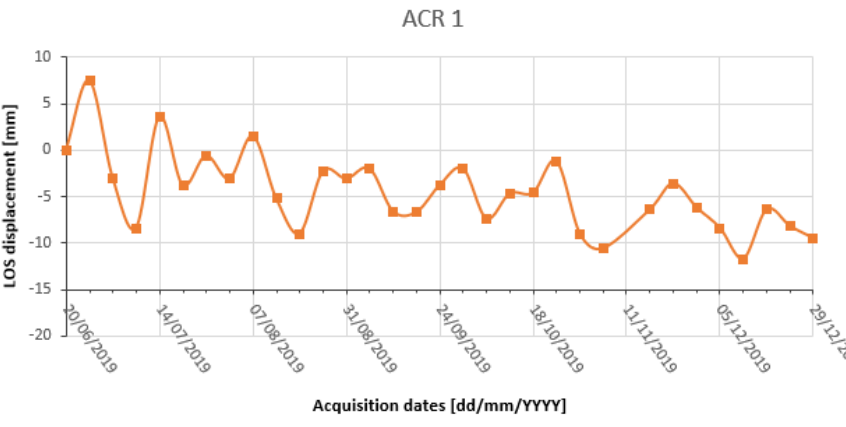
Figure 11. ACR1 displacement time series computed with respect to the reference point located in the bottom left side from Figure